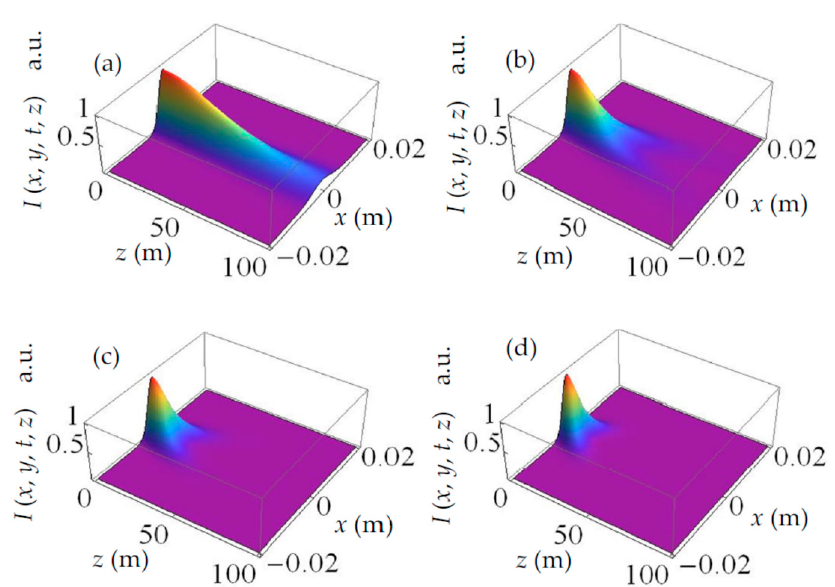
Figure 1. Evolution of spatiotemporal intensity I ( x , y , t , z ) (Equation (20)) of SCTLGSM pulsed beam as a function of propagation distance z and horizontal coordinate x with different beam orders: ( a ) m = 0, ( b ) m = 1, ( c ) m = 2 and ( d ) m = 3.